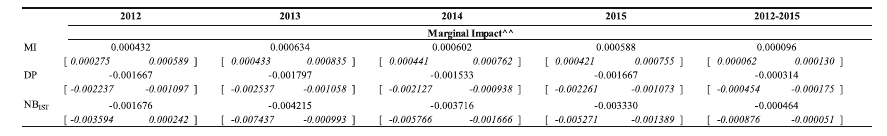
Table 5 Gini decomposition under the scenario of implementation of IST with a contribution proportional to farm income (Scenario IIP). Levels and confidence intervals^ of marginal impact^^ by income source. Years from 2012 to 2015 and whole